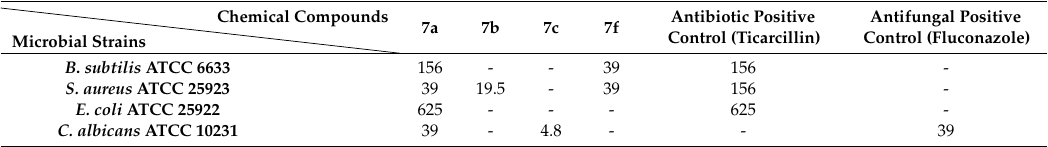
Table 6. The results of the quantitative assay of the antibiofilm activity of the compounds selected by the qualitative screening and the corresponding MBEC value (µg / mL).